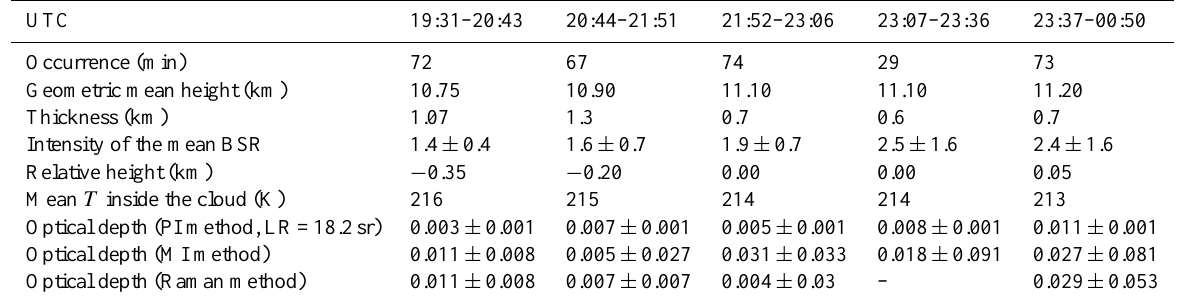
Table 3b. Characterization of cirrus quasi-stationary periods identified at RTV through principal lidar parameters. Temperature values are derived from the operational radiosoundings launched from Pratica di Mare (25km south-west from RTV).